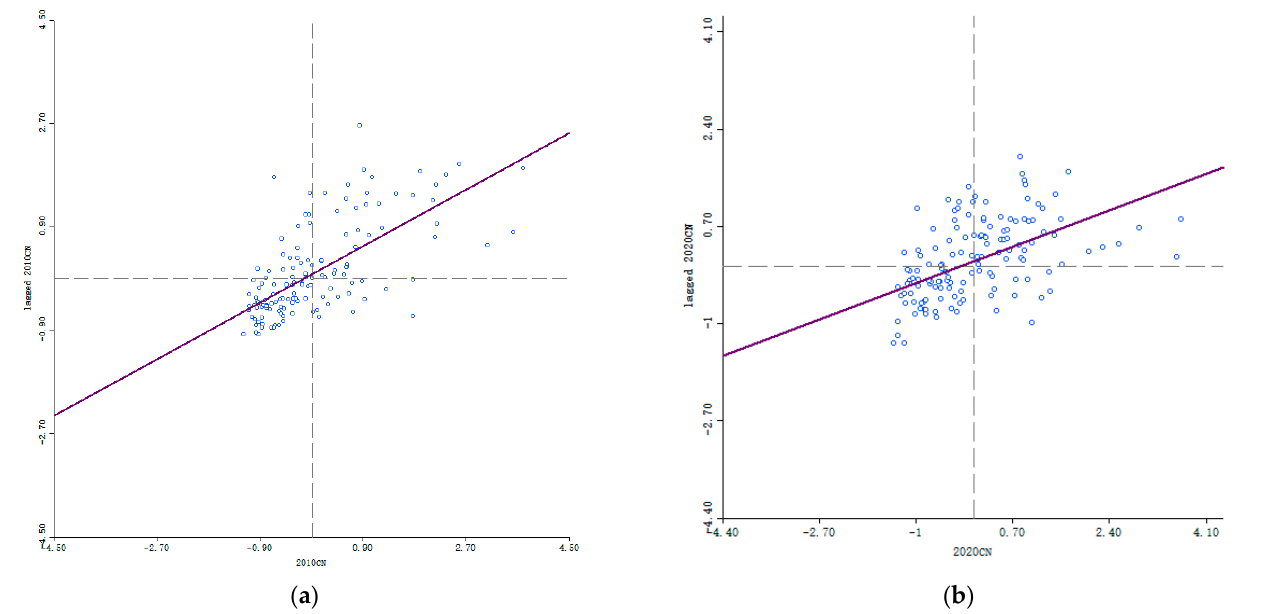
Figure 8. ( a ) Scatterplot of global Moran indices for capacity scores in 2010; ( b ) Scatterplot of global Moran indices for capacity scores in 2020.